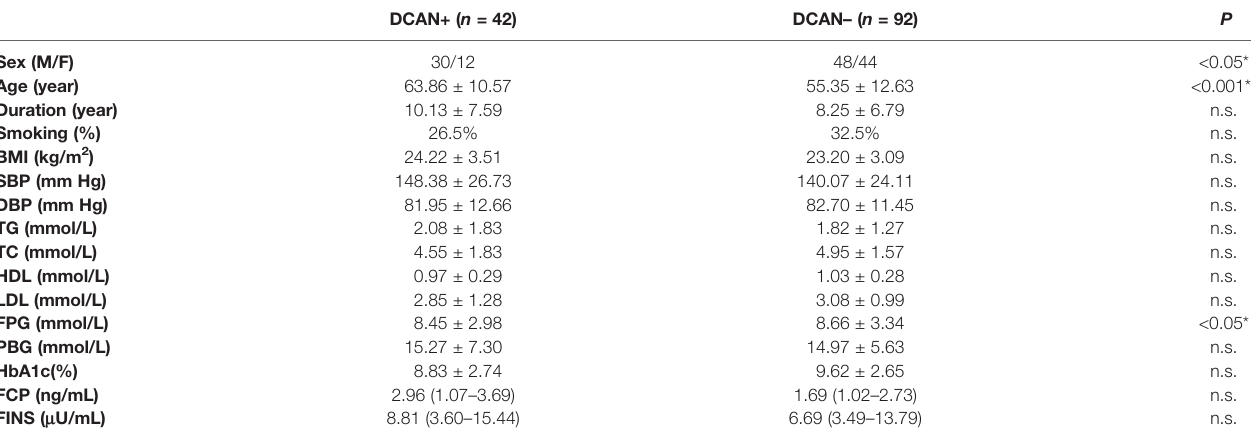
TABLE 1 | Clinical characteristics of patients with T2DM and DCAN versus those without DCAN.